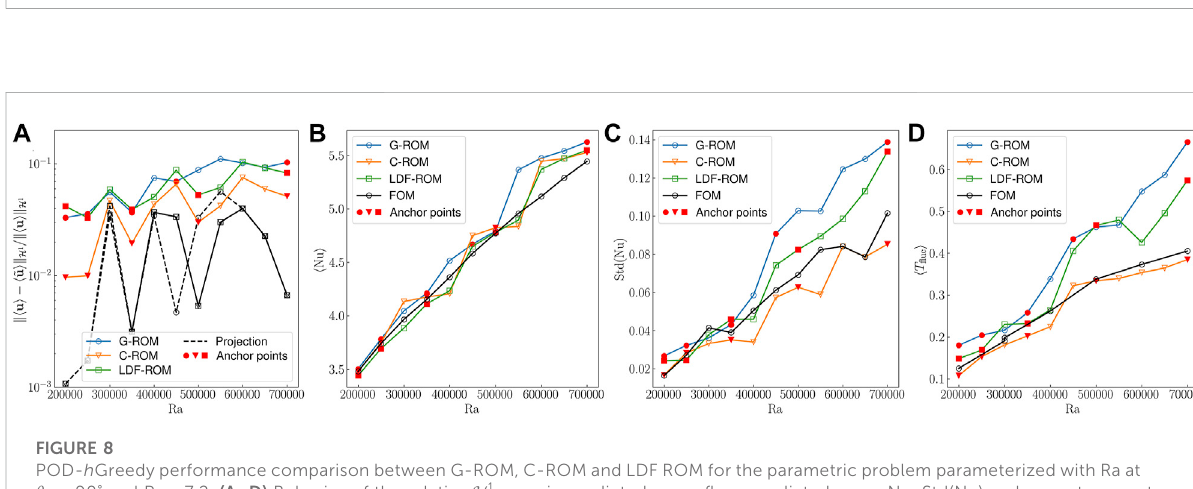
(cid:1) 2 × 10 5 , Ra p (cid:1) 7 × 10 5 , Ra p (cid:1) 2 . 5 × 10 5 , Ra p (cid:1) 3 . 5 × 10 5 , Ra p (cid:1) 5 × 10 5 for C-ROM 1 2 3 4 5